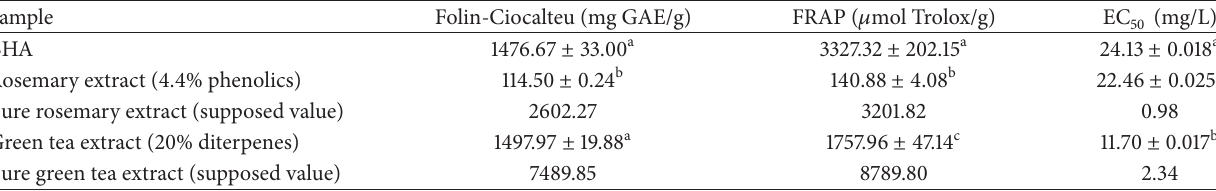
Table 1: Antioxidant capacity values according to the different